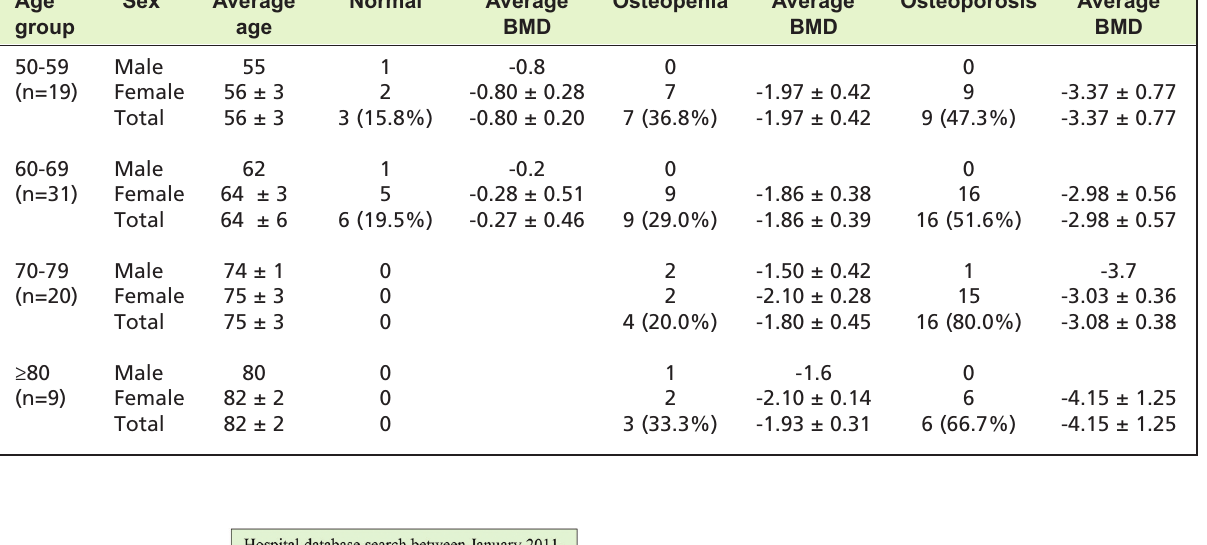
Bone Mineral Density Data Presented as T-scores by Age Category and Sex Table II: